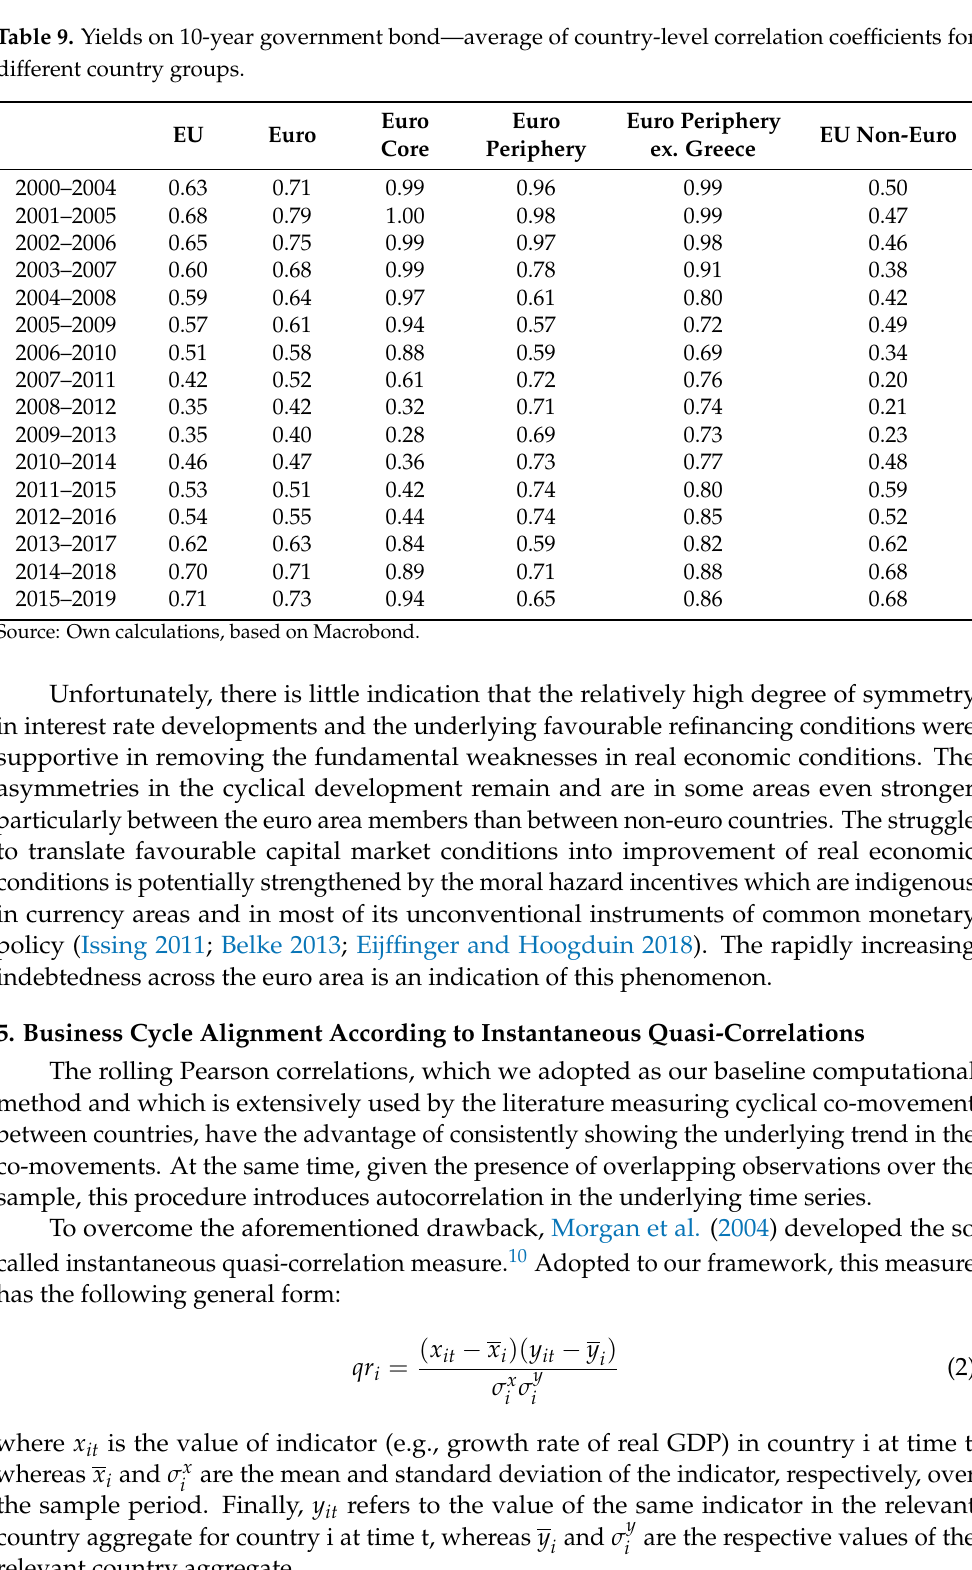
Euro Euro Euro Periphery EU Core Periphery ex. Greece